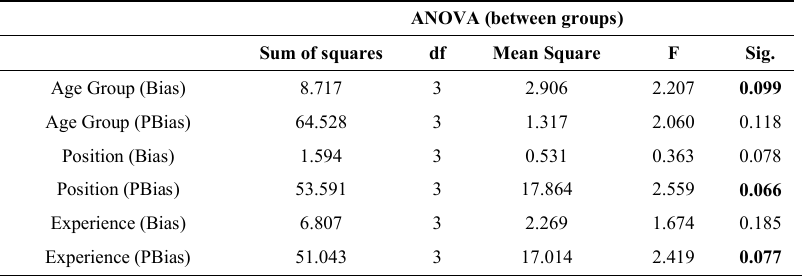
Table 5. ANOVA comparison for the independent variables: "Age Group", "Position", and "Field